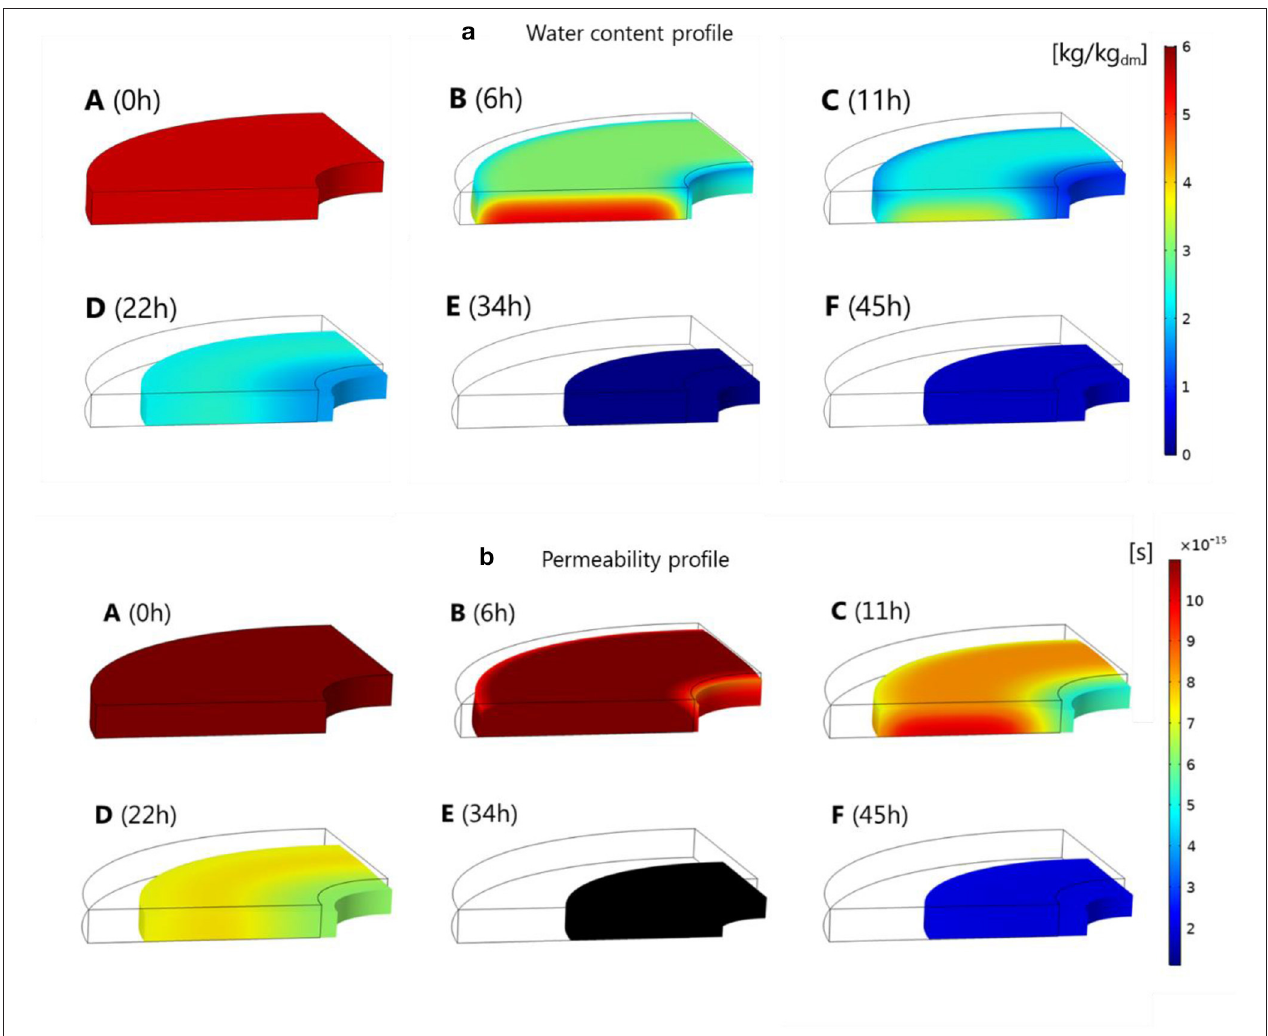
FIGURE 8 | (a) Base case water content and (b) permeability profiles in the deformed apple slice at different point of drying time. Every drying point (A–F) corresponds to the point in Figure 7 .